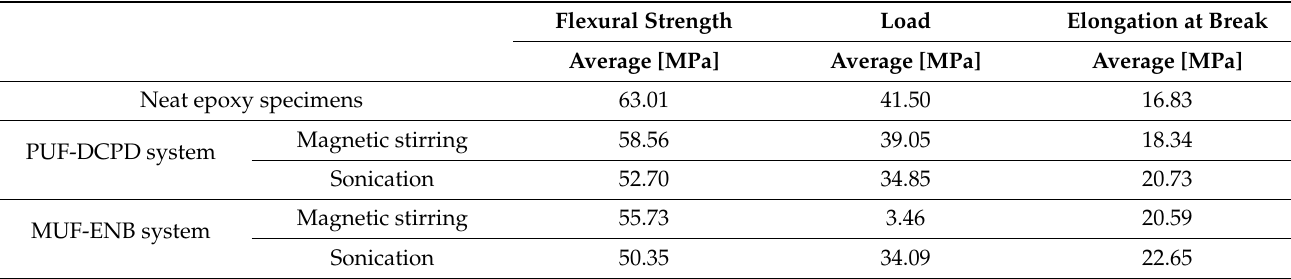
Table 6. Three-point bending results comparison for the two dispersion methods.